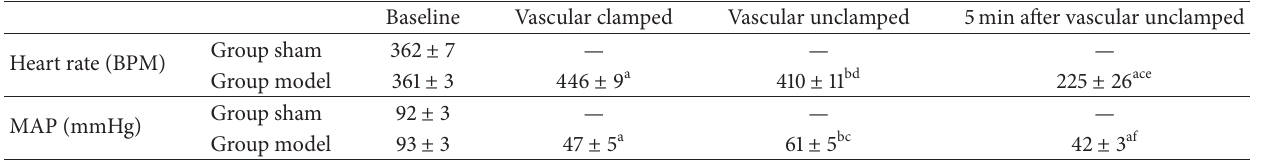
Table 3: Hemodynamic changes during OALT in rats.